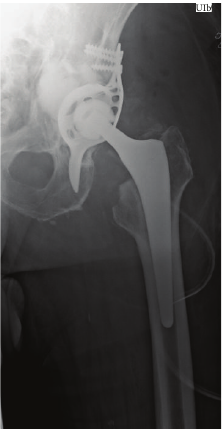
Figure 3: Radiograph of left hip a.p. (supine) on the second day